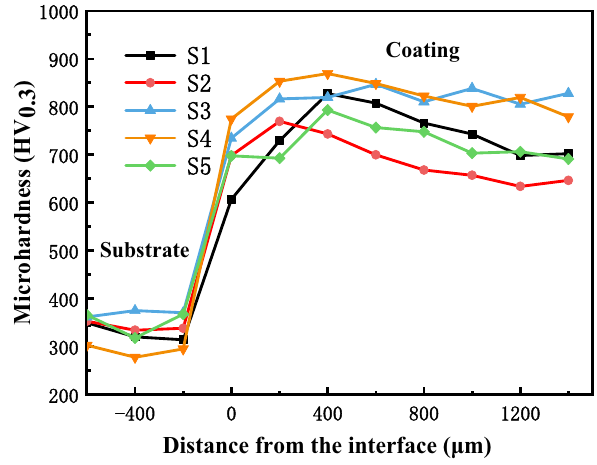
Figure 8: Microhardness distribution of the cladding layers with di ff erent content of Y 2 O 3 fl uorine during the solidi fi cation process. Elements O and F are found at Point 1 and Point 3 [ 34 ] .